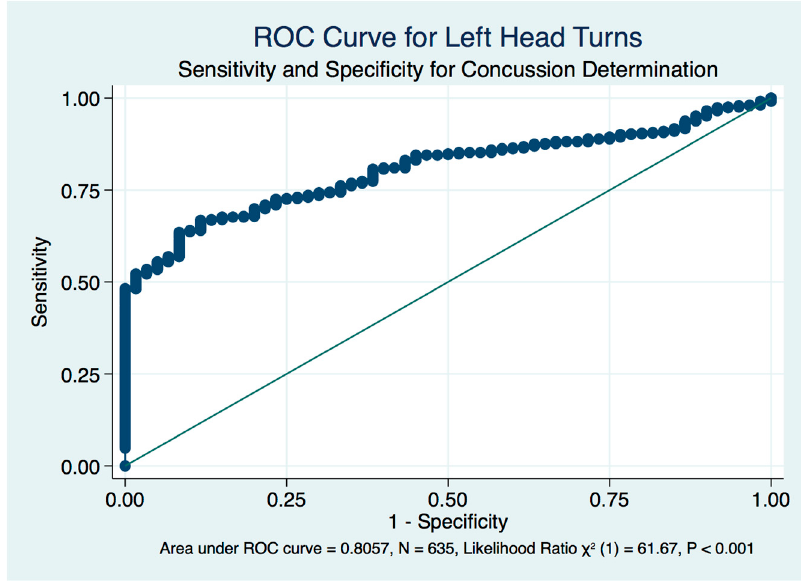
Figure 11. ROC curve for left head turn, eyes closed perturbed testing in concussion determination.